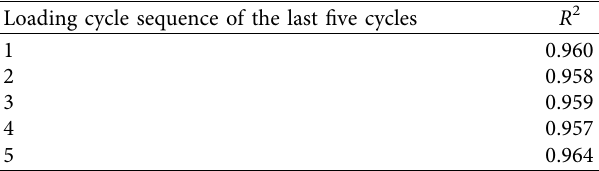
Figure 6: Relationship between the FBG wavelength amplitude and strain level. Table 5: Determination coefficient R 2 between the FBG sensor and the